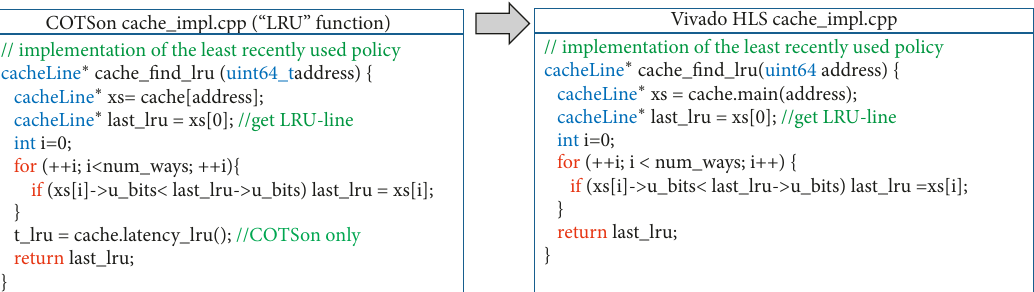
Figure 8: Example of translation of the timing model of the LRU (least recently used) function from the COTSon (left side) to the Vivado HLS (right side).